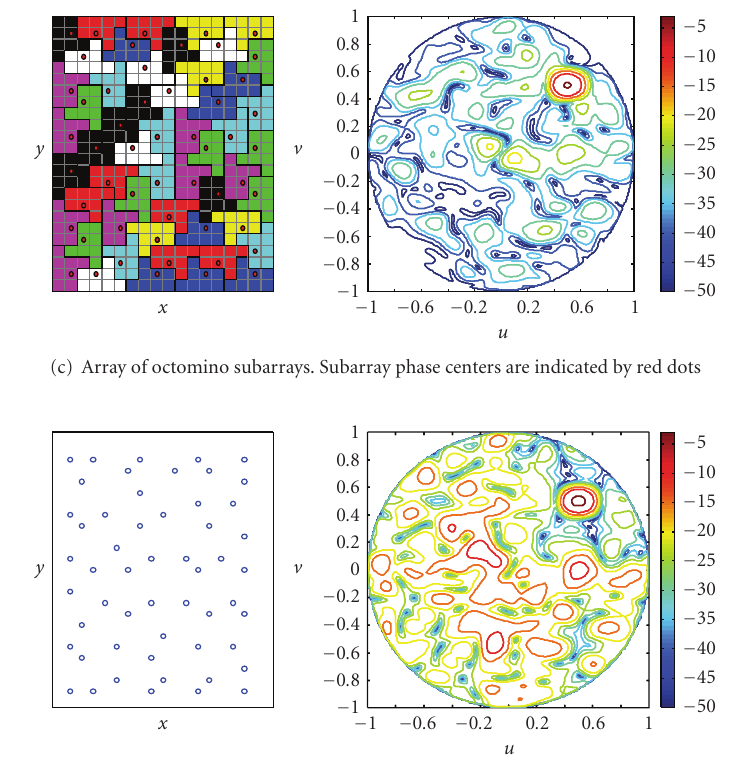
Figure 4: Sidelobe structure for 18 × 24 element array of 54 subarrays of rectangular or L-octomino